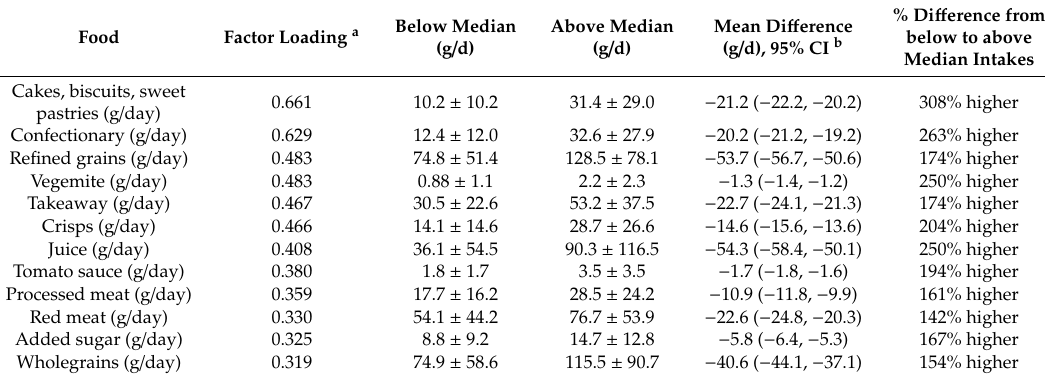
Table 4. Food group intake for the non-core foods dietary